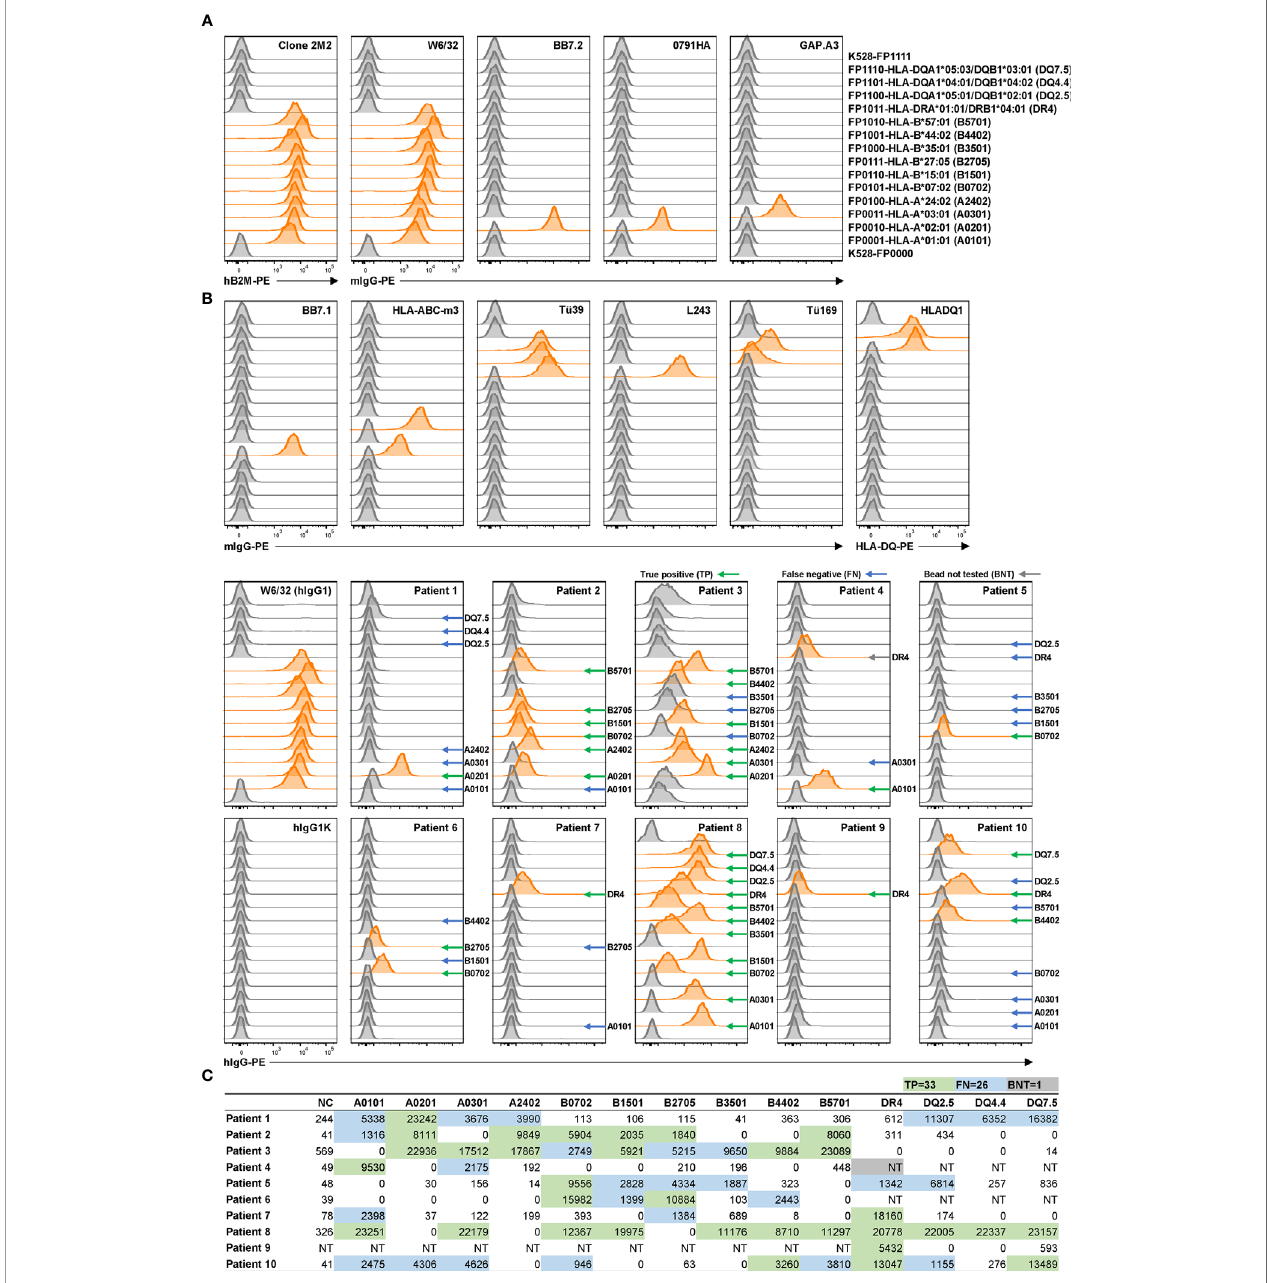
FIGURE 2 | Application of reporter cell line assay in multiplex detection of anti-HLA antibodies in serum samples from allo-sensitized patients. (A) K528-derived fl uorescence-barcoded reporter cell lines were transduced to express HLA class I molecules along with human b 2M or class II molecules along with human CD74. (A) The resultant cell lines were pooled, and the surface expression of HLA molecules on individual cell lines were validated with a panel of reference monoclonal antibodies. Example gating strategy is shown in Figure S3 . Demultiplexed reporter cell lines with MFI values above three-fold of the average MFI value of internal control cell lines (K528-FP0000 and K528-FP1111) were scored as positive and the histograms were highlighted in orange. (B) Multiplex detection of anti-HLA antibodies with 10 serum samples from allo-sensitized patients. W6/32 (hIgG1) was used as positive control, and hIgG1 k and hIgG1 l ( Figure S4 ) as negative controls in staining. Positive readouts that are also positive in clinical HLA SAB readouts were considered as true positive (TP) and indicated with green arrows. Negative readouts that are positive in bead readouts were considered as false negative (FN) and indicated with blue arrows. Positive readouts that were bead not tested (BNT) in SAB assay are indicated with gray arrows. MFI values are listed in Table S1 . (C) Clinical HLA SAB MFI readouts. The color codes are in accordance with those in B), with TPs in both assays highlighted in green, and TPs in SAB assay while FNs in reporter cell assay in blue. HLA alleles are listed in abbreviations as indicated in parentheses in (A) . For class II molecule lines, bulk cell line after antibiotic selection were